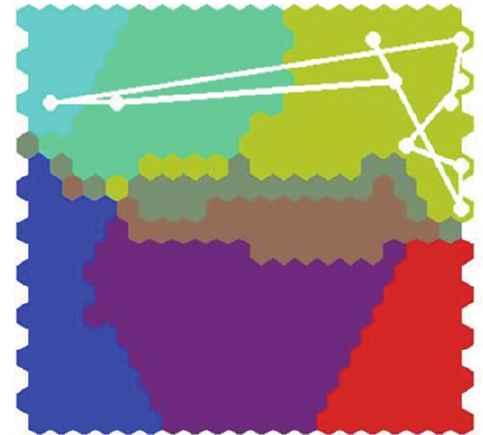
Figure 19: SOM test for perimeter data.